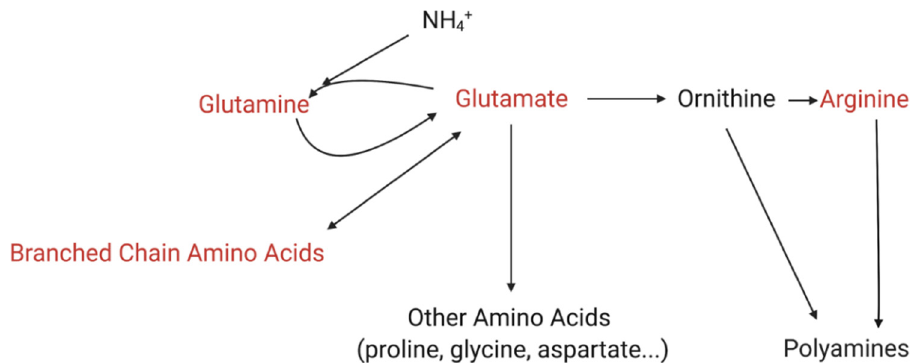
Figure 7. Simplified schematic demonstrating the relationship between ammonium assimilation and metabolism of glutamine, glutamate, branched chain amino acids, and arginine. These metabo- lites are indicated by a red font. Glutamate is the precursor of other amino acids in the cells, and a number of pathways related to their metabolism were identified in the enrichment analysis (see Figures 3 and S2). The figure was created with BioRender.com.